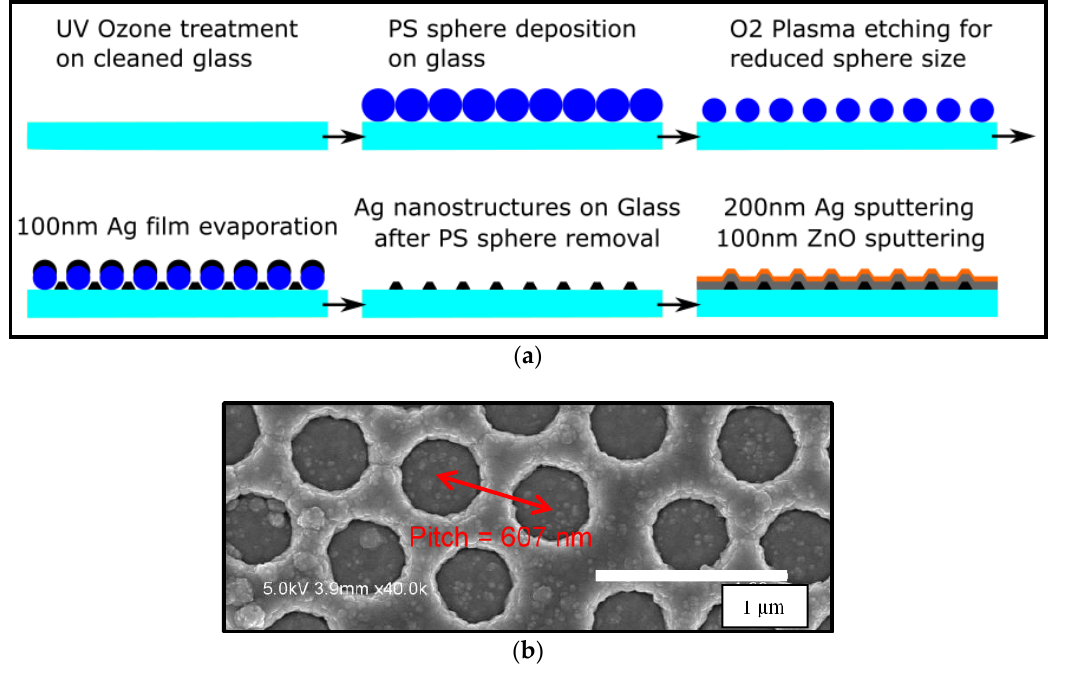
Figure 1. ( a ) Fabrication process and ( b ) Top view SEM image of hexagonal back reflectors (pitch = 607 nm) taken after the final step in Figure 1a.